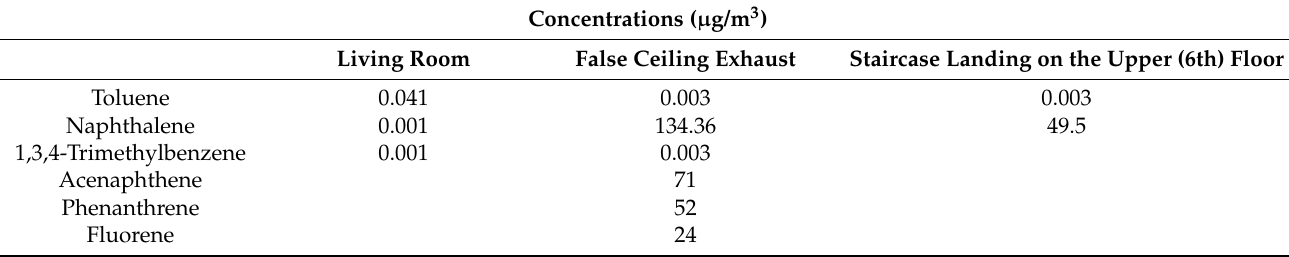
Table 6. The concentrations of the air-borne contaminants one year after the remediation